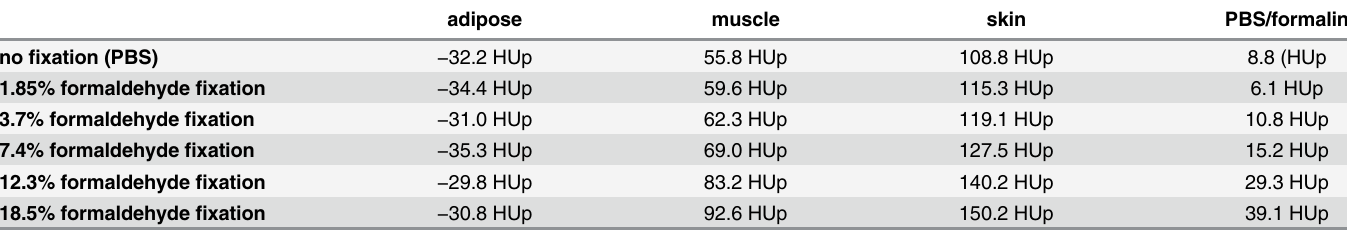
Table 2. Effect of formaldehyde concentration on the quantitative phase-contrast Hounsfield unit of adipose tissue, muscle tissue and skin. For higher formaldehyde concentrations, the increase in the Hounsfield unit of muscle tissue and skin correlates with the Hounsfield unit of the formaldehyde solution